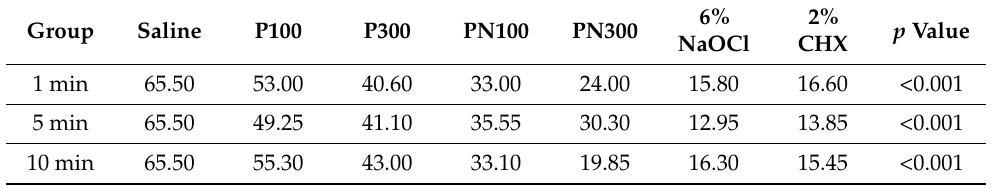
Table 1. Comparison of mean rank in between groups at 1, 5, and 10 min, 200 µ m (Kruskal–Wallis).